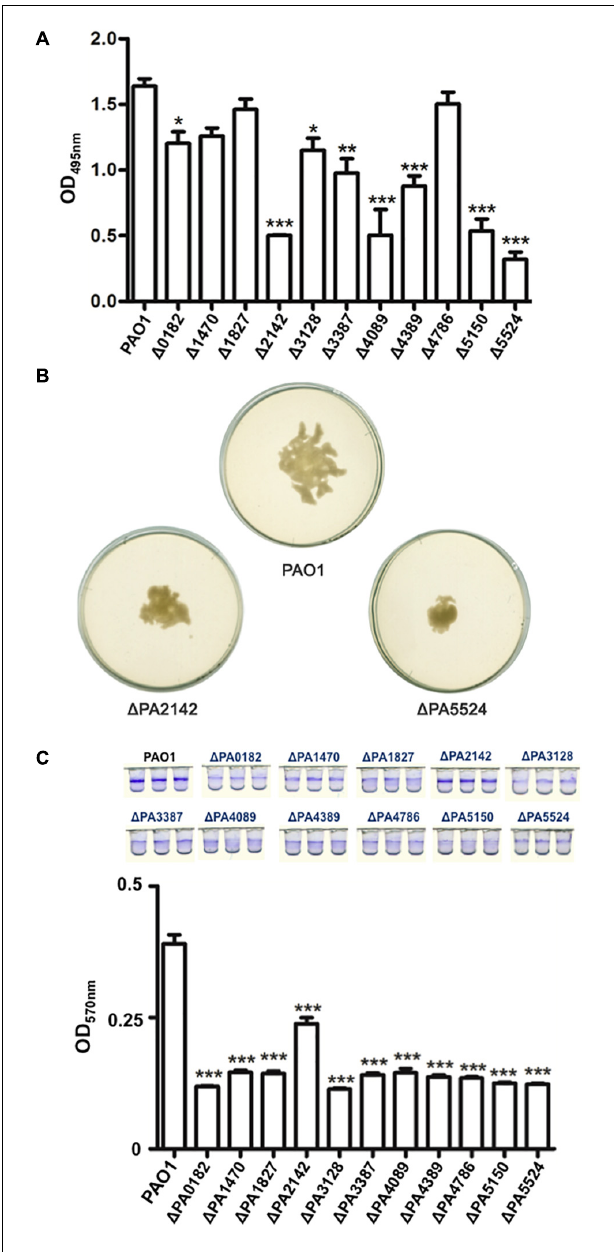
FIGURE 3 | Analysis of LasB activities, swarming motility and biofilm formation of P. aeruginosa strains. (A) LasB protease activities in culture supernatants of P. aeruginosa strains were measured using a Congo red-elastin dye release assay. Data are the mean ± standard deviation of triplicate measurements. Pair-wise comparisons were made between wild type strain PAO1 and OAR mutant strains by Student’s t -test. ∗ Significant difference, P < 0.05. (B) Assay of swarming motility of P. aeruginosa strains on 0.5% agar plate. (C) Analysis of biofilm formation by P. aeruginosa strains using crystal violet stain. The amount of biomass in the biofilm was measured indirectly with spectrometry at 595 nm. Three independent repetitions were performed. Black bars represent standard deviations. Pairwise comparisons were made between wild-type strain PAO1 and the OAR mutant strains with Student’s t -test. ∗ Significant difference, P < 0.05; ∗∗ Significant difference, P < 0.05; ∗∗∗ Significant difference, P < 0.01. PAO1, P. aeruginosa wild type strain; (cid:49) PAxxxx, P. aeruginosa OAR mutant